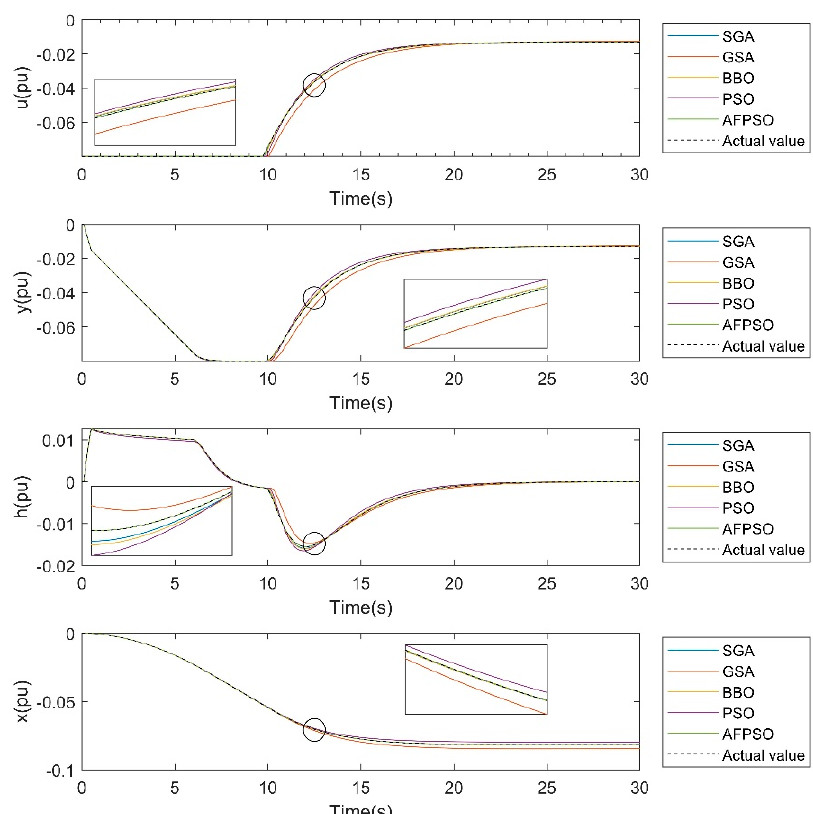
Figure 9. Comparison of the simulated output obtained using di ff erent algorithms (No-load condition).